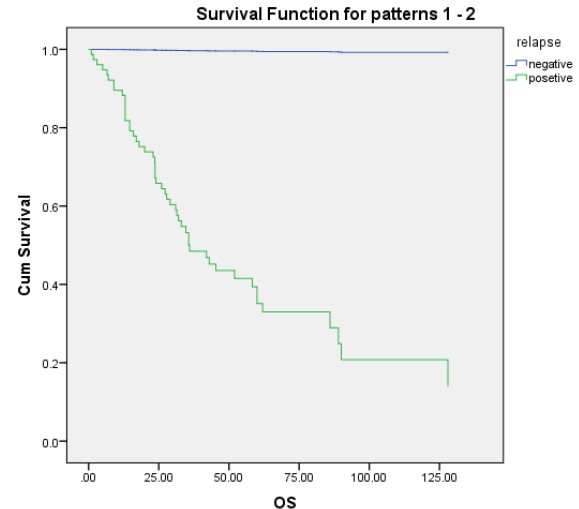
Figure 1. The relationship between tumor recurrence and overall survival in patients with breast cancer.